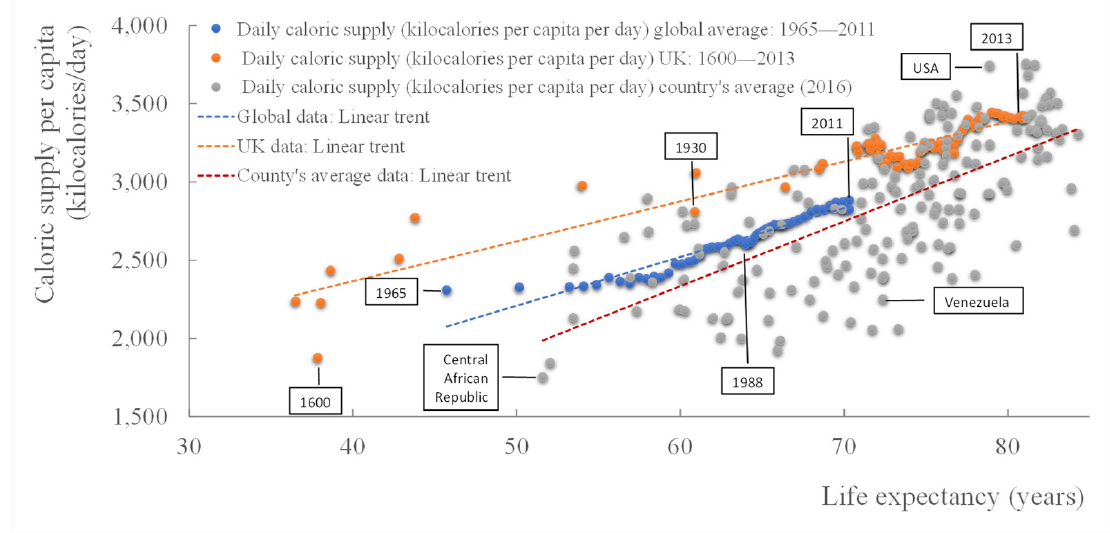
Figure 2. Life expectancy related to daily caloric supply; global average (1965–2011) and 172 countries’ average data (2016) [11] and UK data (1600–2013) [6,8].